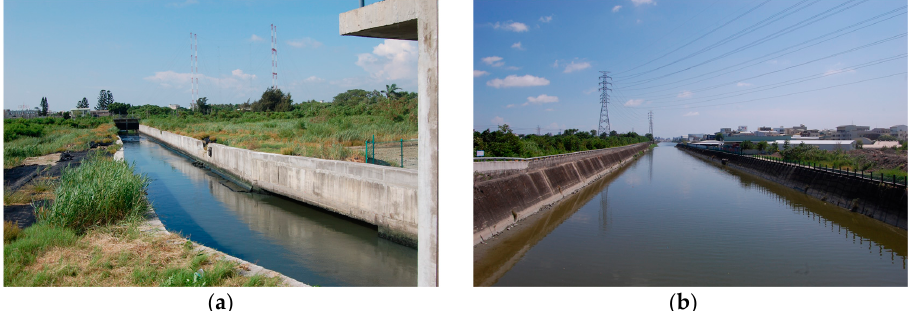
Figure 3. General form of regional drainage channel in Tainan City. ( a ) a small regional drainage channel with width 5 m; ( b ) a large regional drainage channel with width 20 m.